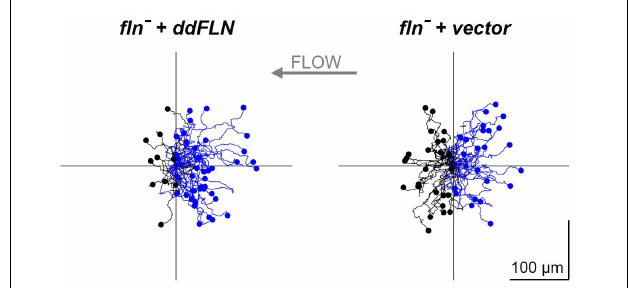
FIGURE 6 | Filamin is required for shear flow-induced migration. fln - cells expressing RBD-GFP and either mCherry-tagged ddFLN or empty vector were subjected to continuous flow at 6 dyn/cm 2 and were imaged using brightfield illumination under 200X magnification every 10 s for 20 min. Individual cells were tracked starting 2 min after initiation of flow for the remaining 18 min. Tracks of 50 individual cells for each condition from one representative experiment are shown. Cells that showed displacement in the direction opposite of the flow are shown in blue; the rest are in black. Average data for cell speed and directionality from three separate experiments is shown in Table 2 .